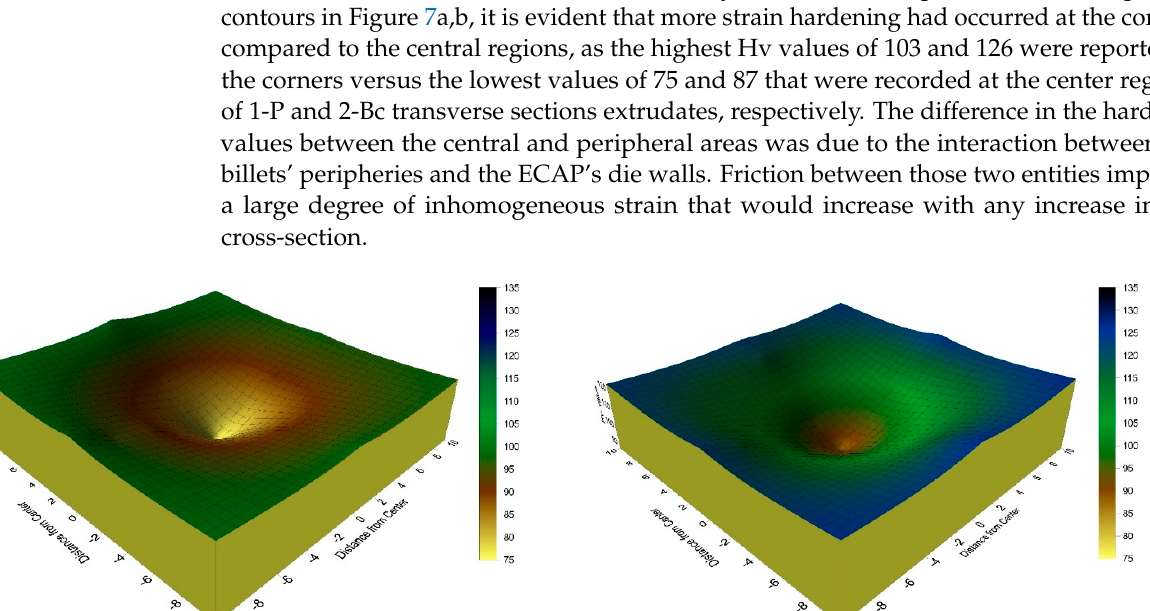
Figure 7. Color-coded contour maps for the Hv values recorded on the top TS of the ECAP-processed rods through ( a ) 1-P and ( b ) 2-Bc.